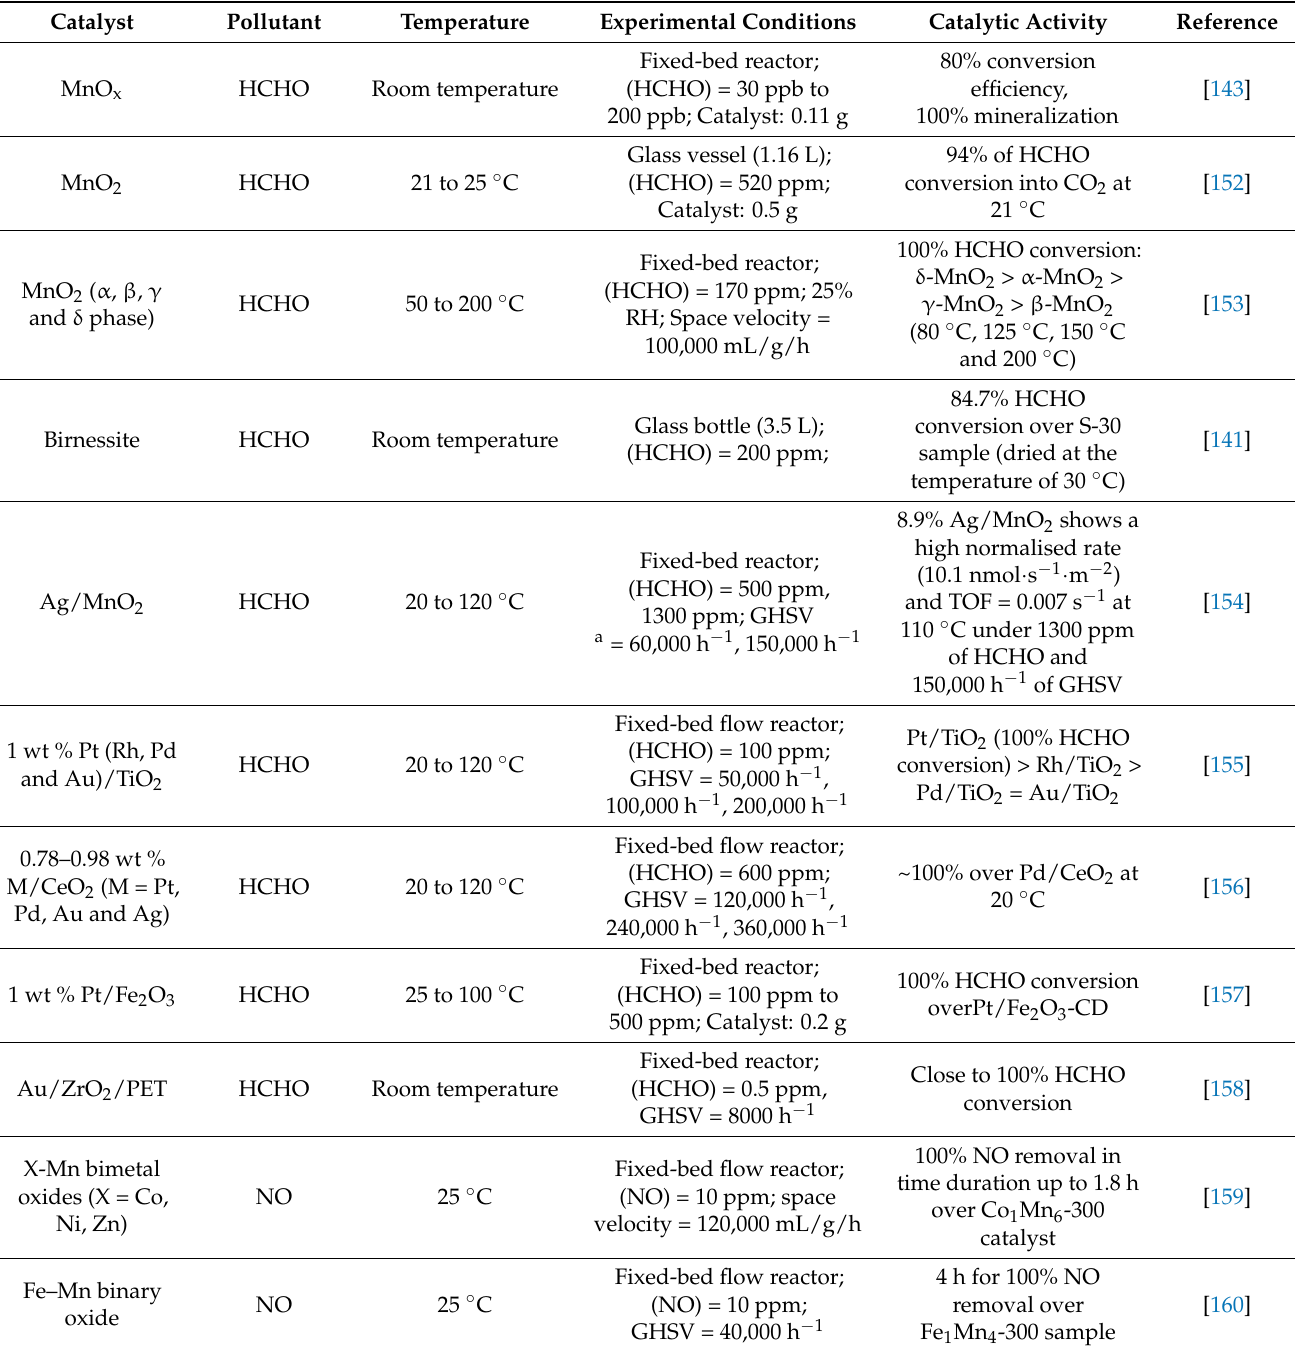
Table 3. Summary of typical catalysts for the removal of HCHO and NO x at ambient